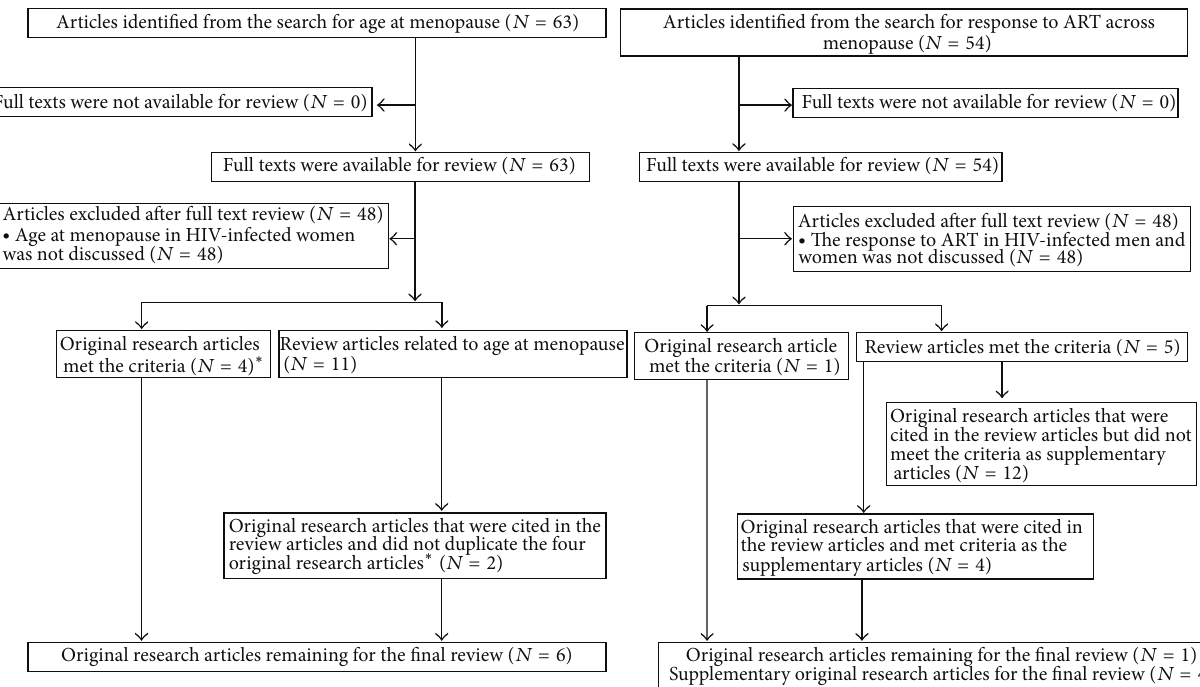
Figure 3: Flowchart of article selection and exclusion for the systematic review: HIV and menopause,